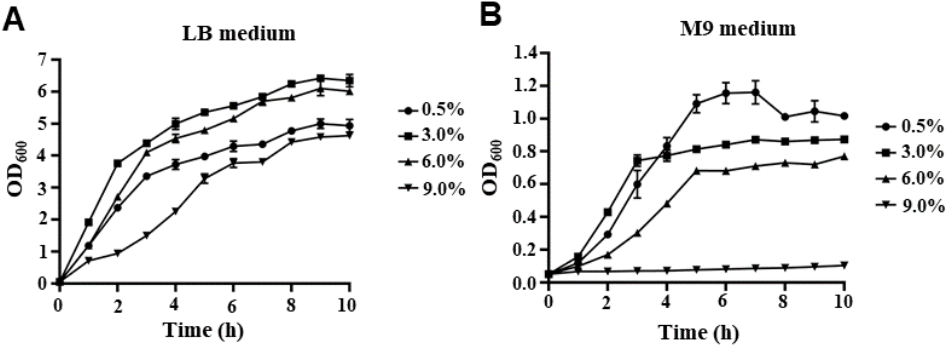
Figure 1. The growth curves of V. parahaemolyticus . V. parahaemolyticus strain RIMD2210633 was grown in LB ( A ) or M9 ( B ) mediums with 0.5%, 3%, 6%, and 9% NaCl. The bacteria were cultured at 37 °C by shaking at 180 rpm. The OD 600 of each culture condition was monitored at the indicated times until the cultures reached the stationary